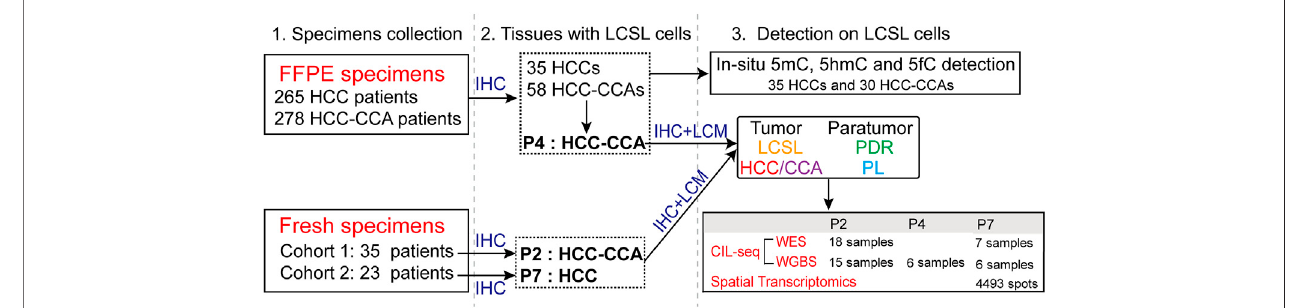
FIGURE 6 | An outline of samples used and experiments performed in this study. FFPE and fresh specimens of primary liver cancer patients were collected and screened forLCSL cells byEpCAM IHC stainingand tissue/cell morphology.Spatial mutiomics analysis,including in-situ detection ofDNAcytosinemodi fi cations (5mC, 5hmC and 5fC), WES and WGBS analysis (for P2, P4 and P7 tissues) by CIL-seq, and spatial transcriptomics (for P7 tissues), was performed on those specimens with obvious LCSL